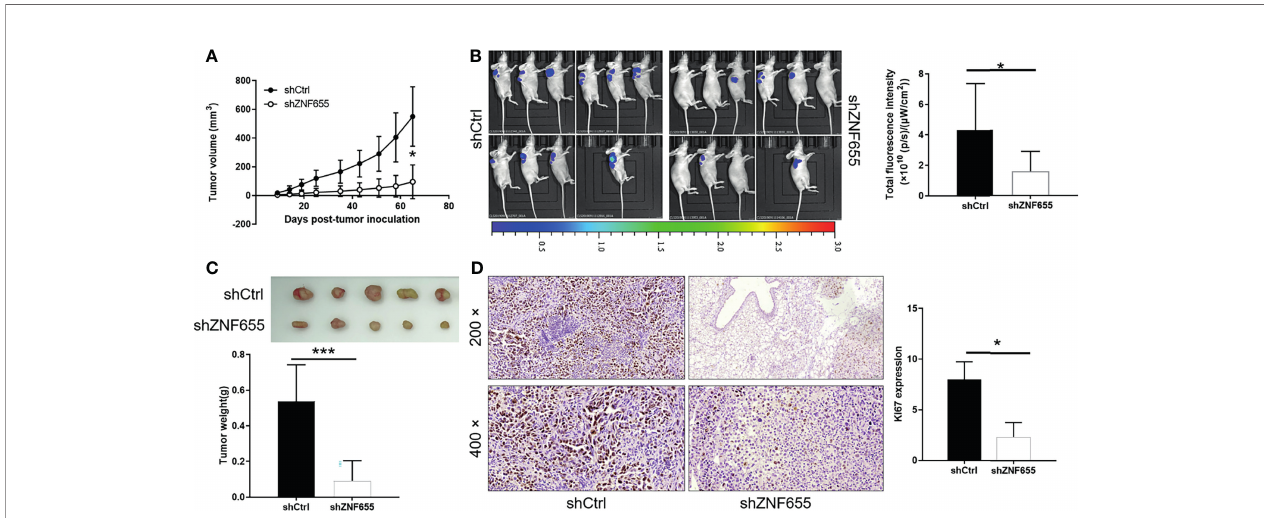
FIGURE 3 | Knockdown of ZNF655 inhibits tumor growth in vivo . (A) The growth of mouse tumors was monitored for 65 days and tumor volume in shCtrl and shZNF655 groups were measured. (B) The total fl uorescent intensity of tumors in the shCtrl group and shZNF655 group was detected. (C) The xenograft tumors were removed from the model mice, and tumor weight was measured after the sacri fi ce of mouse models. (D) The Ki67 index of the removed tumors was evaluated by immunohistochemical staining analysis (×200 magni fi cation and ×400 magni fi cation). The data were expressed as mean ± SD (n ≥ 3), *p < 0.05, ***p <